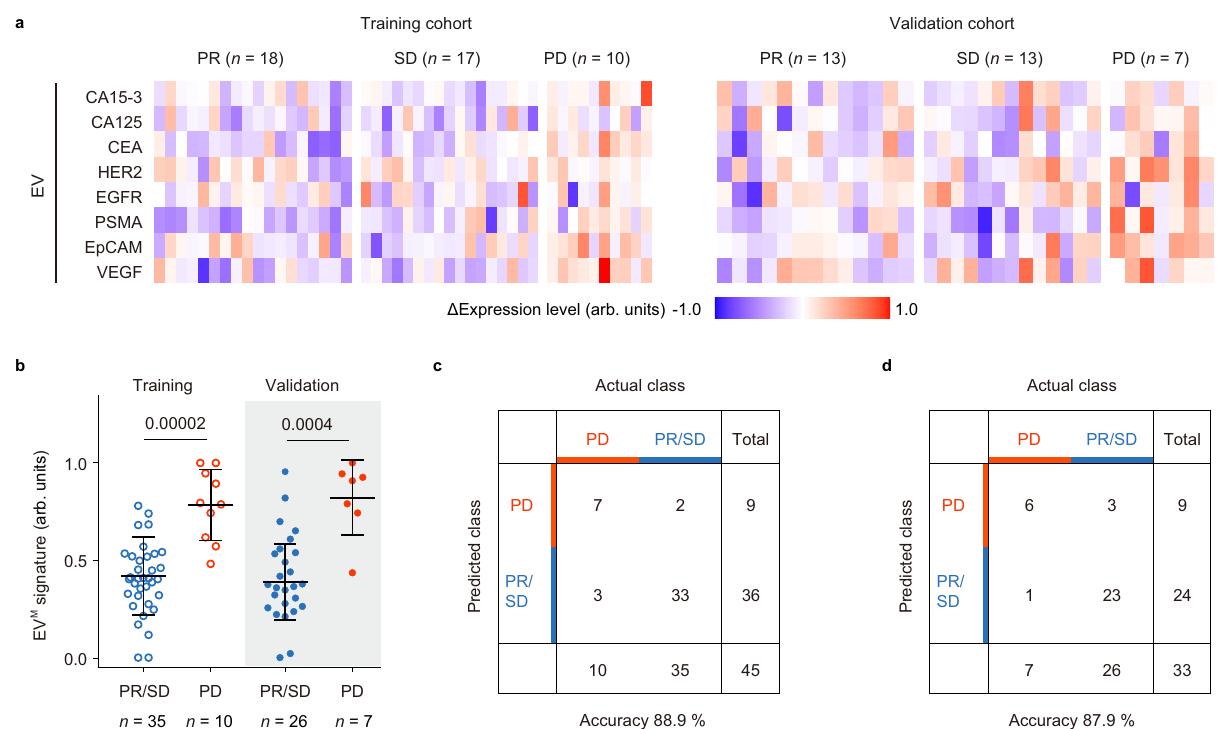
Fig. 4 EV analyses for classi fi cation of MBC treatment response in the training and validation cohorts. a Heatmap of Δ Intensity of EV protein markers for the training cohort involving patients with PR ( n = 18), SD ( n = 17), or PD ( n = 10) and the validation cohort involving patients with PR ( n = 13), SD ( n = 13), or PD ( n = 7). b Values of the EV M signature (the weighted sum of Δ Intensity of eight markers by LDA) in the training cohort (PR/SD: n = 35 samples, void blue dots; PD: n = 10 samples, void red dots) and the validation cohort (PR/SD: n = 26 samples, solid blue dots; PD: n = 7 samples, solid red dots) c , d Confusion matrix showing that the EV M signature had an accuracy of 88.9 % in differentiating PD from PR/SD for the training cohort ( c ) and 87.9% for the validation cohort ( d ). Statistical differences were determined by two-sided, nonparametric Mann – Whitney test ( b ). P values are indicated in the charts. Error bars represent the mean ± s.d. in ( b ). Source data are provided as a Source Data fi